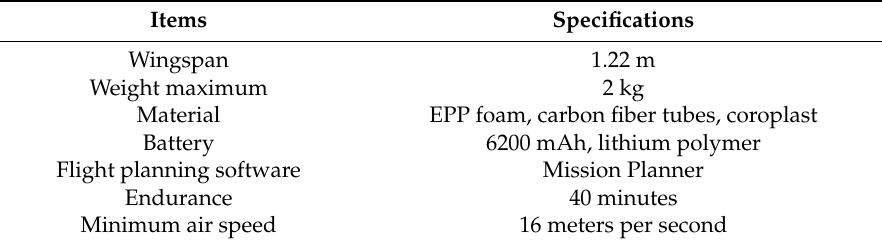
Figure 3. The fixed-wing UAV used in this study. ( a ) Tuffwing fixed-wing UAV. ( b ) The UAV in the take-off position. Table 2. Specifications of the fixed-wing unmanned aerial vehicle (UAV) platform.